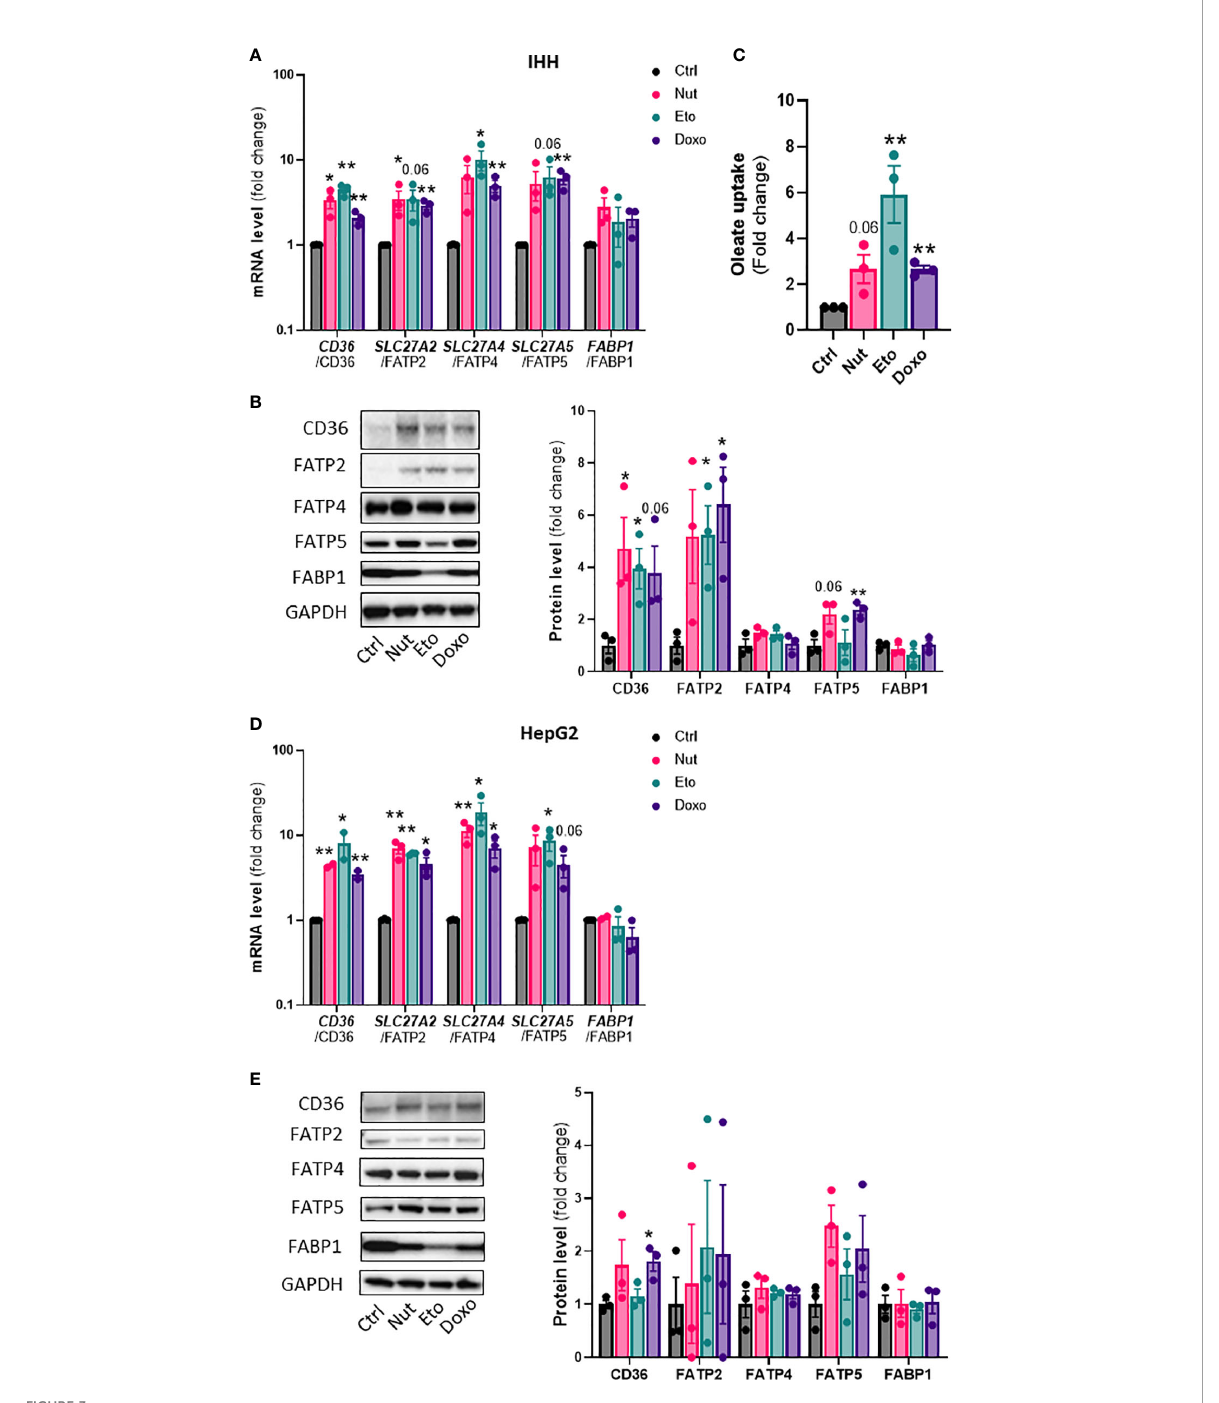
FIGURE 3 Increased expression of lipid transporters and fatty acid uptake in senescent human hepatocytes. Human hepatocytes were treated with nutlin (Nut; 3 µM), etoposide (Eto; 20 µM) and doxorubicin (Doxo; 0,2 µM) for 5 days. mRNA expression of lipid transporters normalized to GAPDH in IHH (A) and HepG2 (D) cells. Western blot analysis and quanti fi cation of lipid transporter protein levels normalized to GAPDH in IHH (B) and HepG2 (E) cells. (C) Fatty acid uptake in IHH hepatocytes. Results are expressed as Mean ± SEM. *P < 0.05, **P < 0.01 indicates a signi fi cant difference compared to control